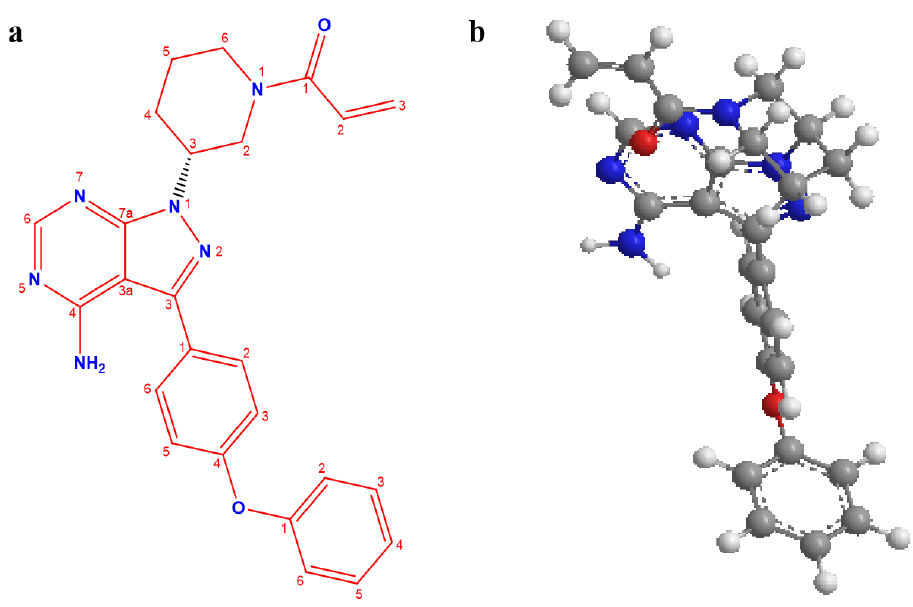
Figure 1. Chemical structure of ibrutinib: two-dimensional ( a ) and three-dimensional ( b ). As per the reported studies, the bioavailability of ITB has been found to be very low